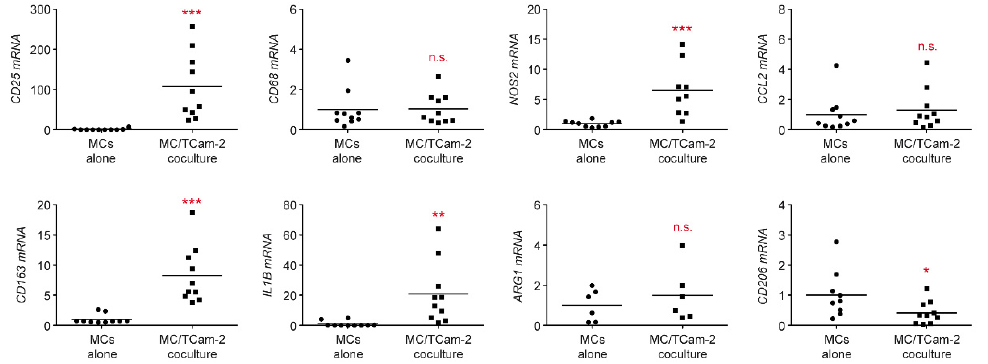
Figure 4. Gene expression analysis of peripheral blood monocytes cocultured with TCam ‐ 2 cells by quantitative RT ‐ QPCR. Monocytes (MCs) were isolated from PBMC of healthy blood donors using magnetic cell sorting and cultured in 6 ‐ well plates either on a monolayer of TCam ‐ 2 cells or alone for 24 h. MCs were collected from both cultures and RNA was prepared for subsequent analysis by quantitative RT ‐ PCR. Relative mRNA levels of CD25 , CD163 , CD68 , IL1B , NOS2 , ARG1, CCL2, and CD206 are depicted as dot plots with a horizontal line representing the mean. Gene expression was calculated by normalization to the housekeeping gene 18SRNA , mRNA levels in MCs cultured alone were arbitrarily set to 1. N = 6–10; PBMC were obtained from 4–5 healthy volunteers. Statistical analysis was performed by unpaired t ‐ test (*: p < 0.05; **: p < 0.01; ***: p < 0.001; n.s.: p > 0.05).